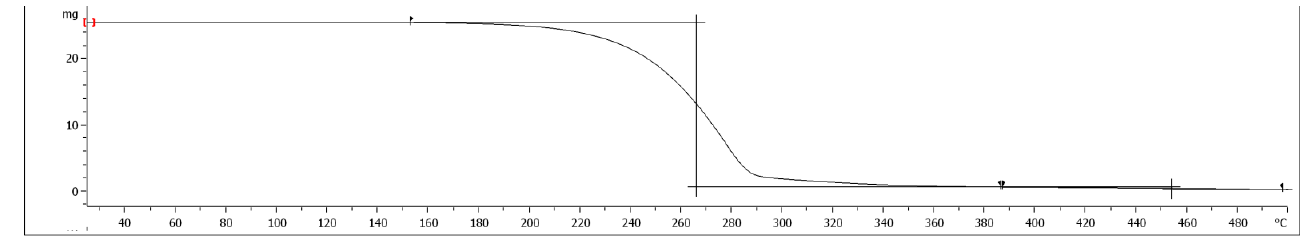
Figure 3. TGA curve of butyl butoxyethyl adipate.